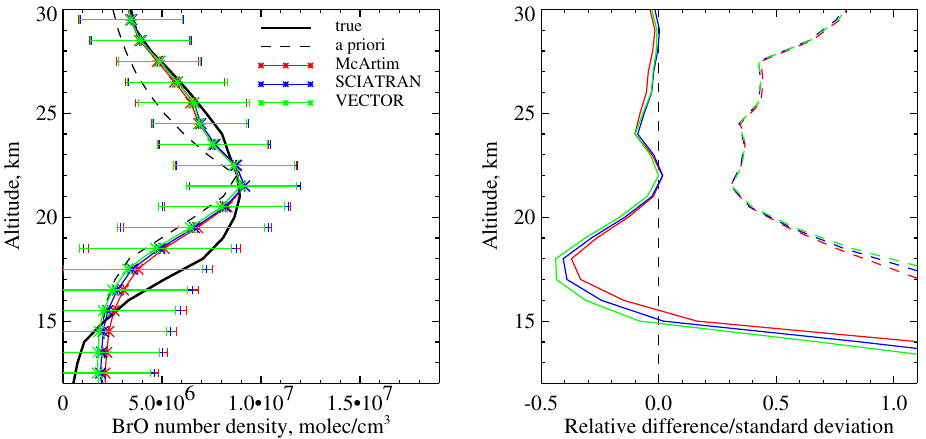
Fig. 13. Same as in Fig. 12 but retrieved with the MPI Mainz